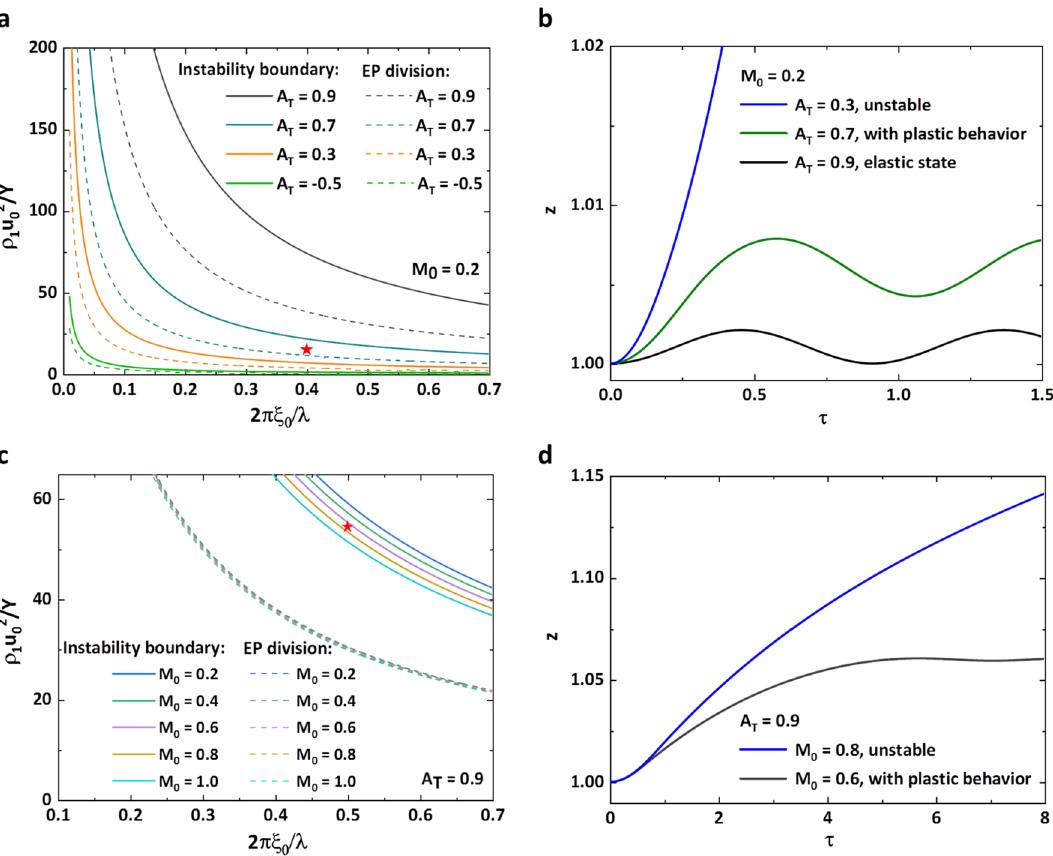
Figure 5. Influences of A T and M 0 on instability boundary and EP division. ( a ) For a fixed M 0 = 0.2, four groups of instability boundary (solid line) and EP division (dash line) with A T = 0.9, 0.7, 0.3, − 0.5 are plotted. A point between instability boundary and EP division of A T = 0.7 is designated with red star. ( b ) The growth factor of red star in figure ( a ) as A T varying. ( c ) For a fixed A T = 0.9, five groups of instability boundary (solid line) and EP division (dash line) with M 0 = 0.2, 0.4, 0.6, 0.8, 1.0 are shown. Also a red star between M 0 = 0.6 and 0.8 is designated. ( d ) The growth factor of red star in figure ( c ) as M 0